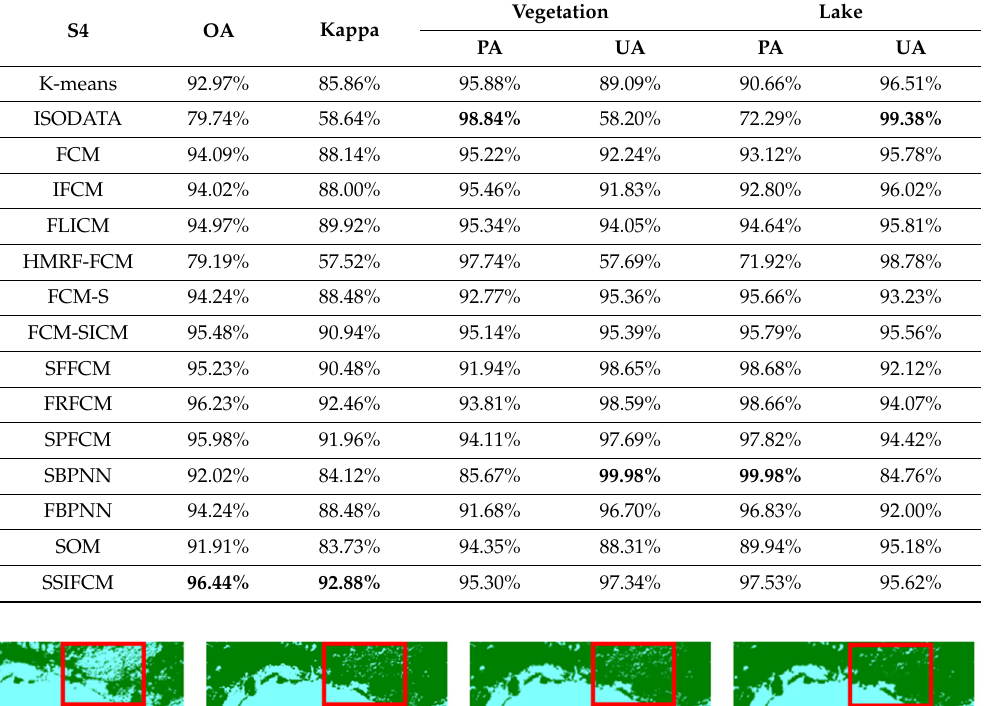
proposed algorithm obtains the optimal classification accuracy. This collection of trials demonstrates the object-level classification algorithm’s ability in “suppressing” salt and pepper noise.